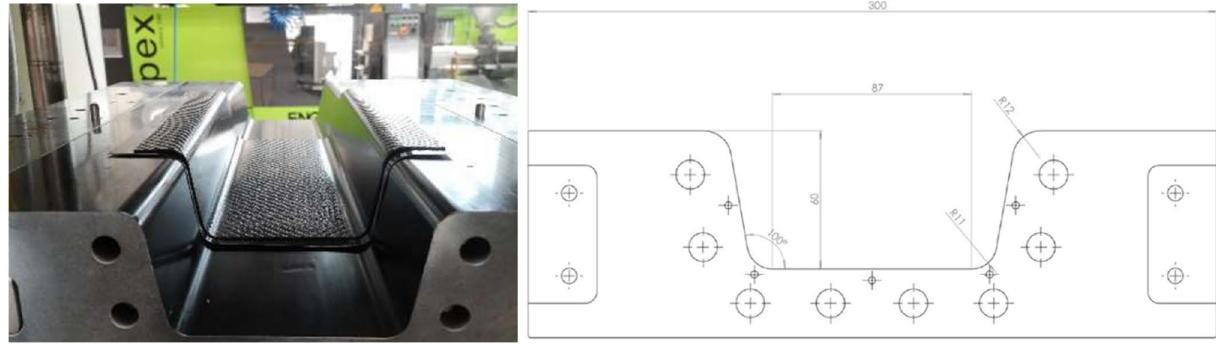
Fig. 1 Tool for press production of the generic component